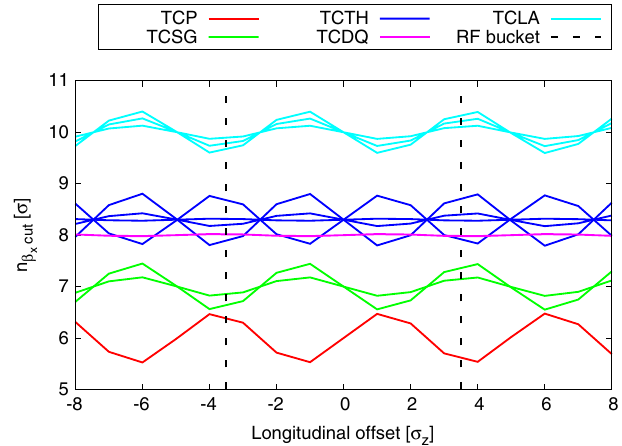
FIG. 9. (Color) Phase space cut from crab dispersion (for n (cid:4); cut between 5 (cid:7) and 11 (cid:7) ), with the hierarchy of primary (TCP), secondary (TCSG), tertiary (TCTH), beam dump (TCDQ) hori- zontal collimators, and shower absorbers (TCLA).